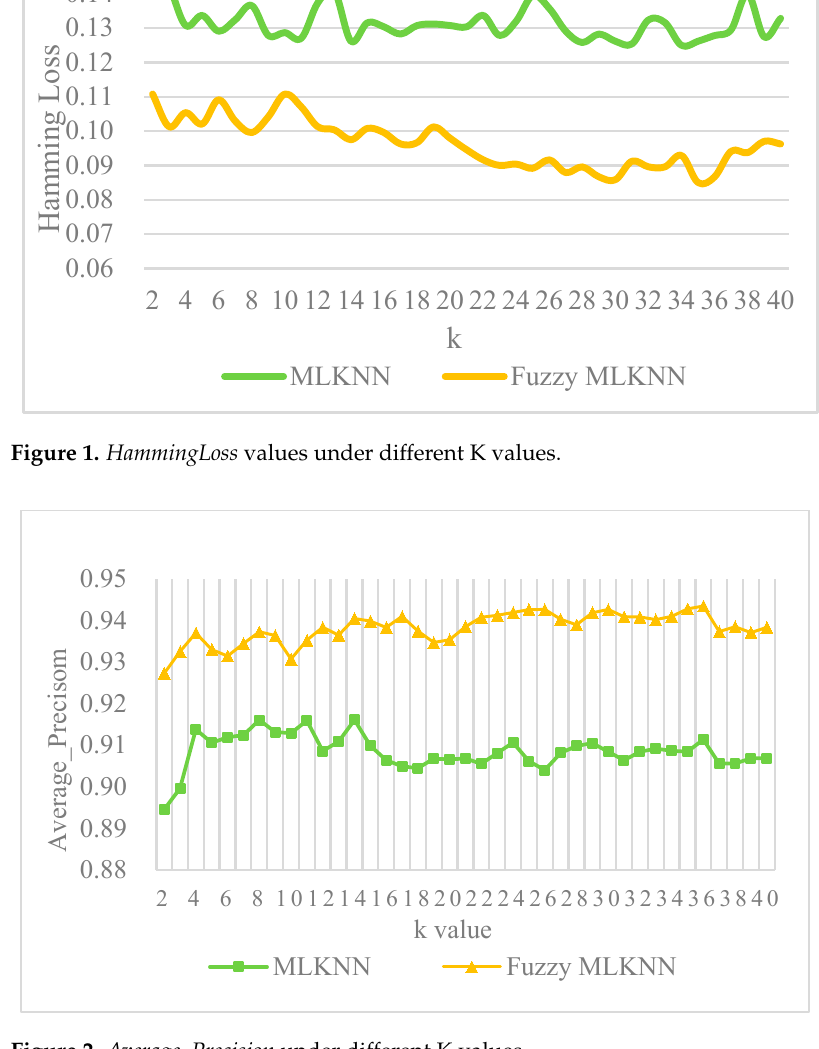
Figure 3. RankingLoss under different K values.